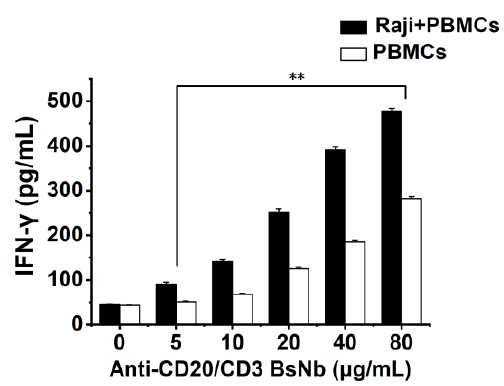
Figure 9. Detection of the effect of anti-CD20/CD3 BsNb on the secretion of cytokines by PBMCs in the presence or absence of Raji cells by ELISA. Raji cells were cultured in PerkinElmer Cell Carrier for 12 h with 3 parallel wells in each group, and effector cell PBMCs with the effector: target ratio = 10:1 were added to the experimental group. PBMCs cells were cultured in PerkinElmer Cell Carrier for 12 h with three parallel wells in each group and the same volume of medium added as the control group. The final concentrations of anti-CD20/CD3 BsNb were 80 μg/mL, 40 μg/mL, 20 μg/mL, 10 μg/mL, 5 μg/mL and 0 μg/mL were added to the Wells. The level of IFN- γ was determined with the ELISA method and calculated from the standard curve (** p < 0.01) .